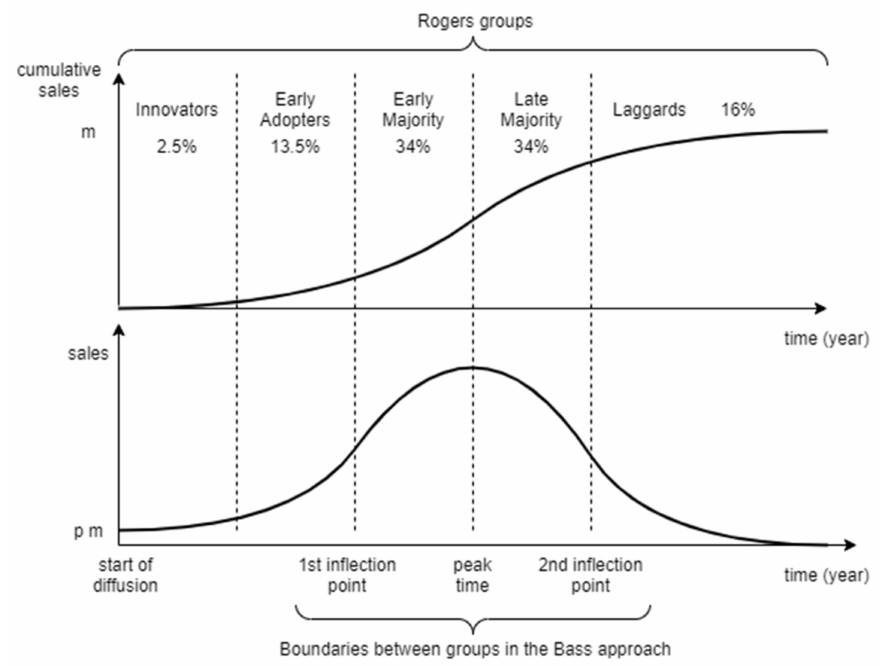
Figure 4. Sales and cumulative sales in the Bass model with Rogers group